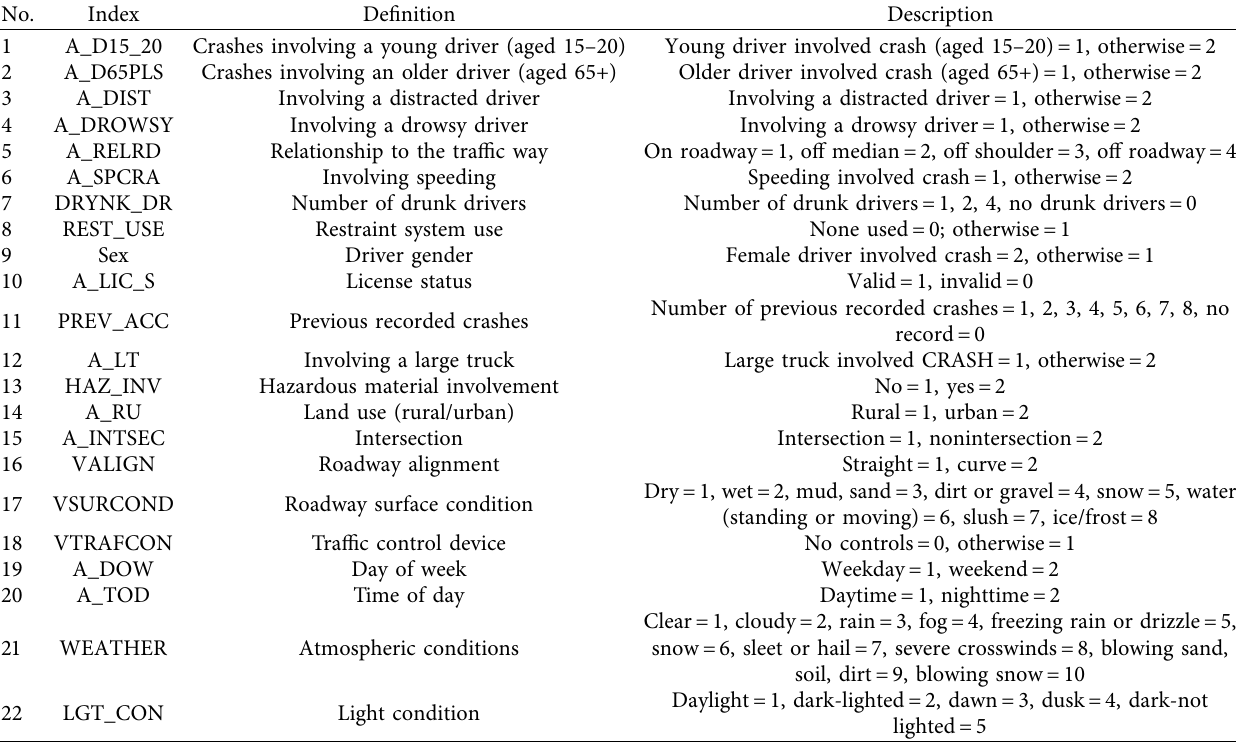
Table 1: Indicator set of accident cost impact factors.